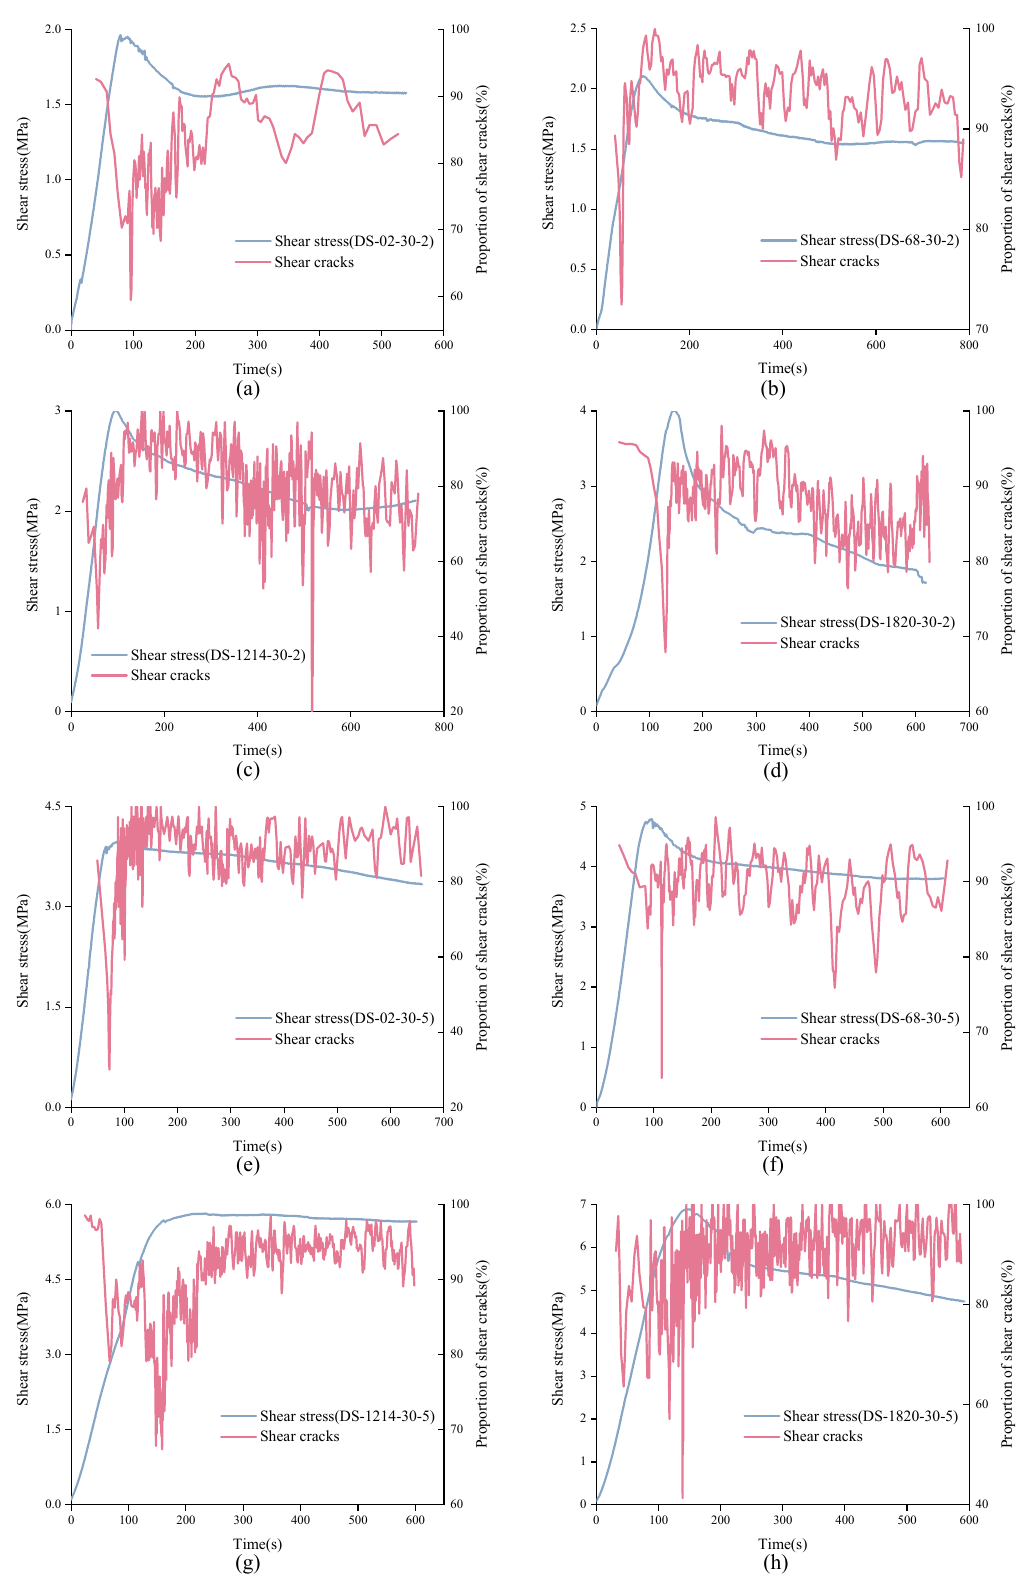
Figure 18. Variation trend of real-time shear cracks’ proportion of anchored structural planes with anchorage angle of 30°. ( a ) DS-02-30-2 ( b ) DS-68-30-2 ( c ) DS-1214-30-2 ( d ) DS-1820-30-2 ( e ) DS-02-30-5 ( f ) DS-68-30-5 ( g ) DS-1214-30-5 ( h ) DS-1820-30-5.